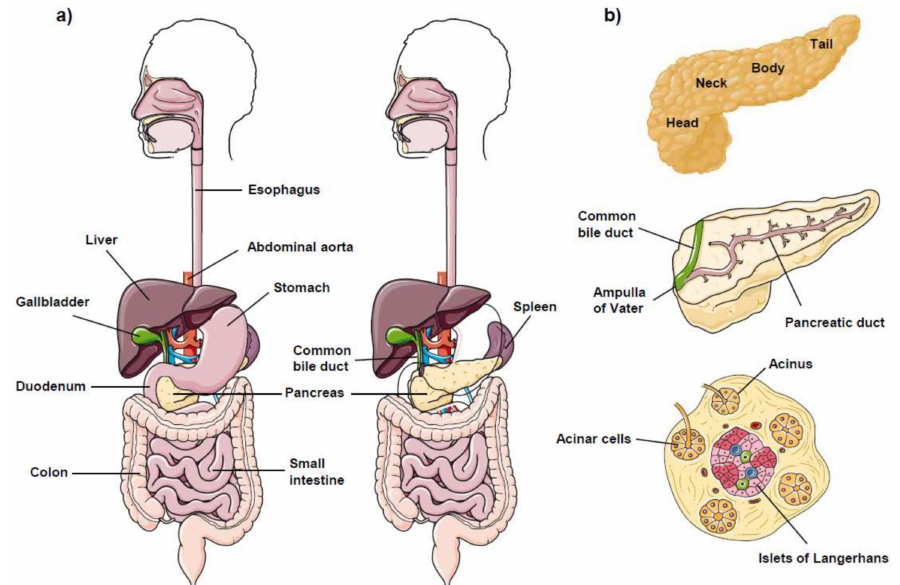
Figure 1. Pancreas anatomy. ( a ) Location and anatomical relationships between the pancreas and organs surrounding it in the abdomen. The pancreas is located behind the stomach, and the head of the pancreas is surrounded by the C-loop of the duodenum. ( b ) (Upper) The pancreas is divided into four major anatomical regions: head, neck, body, and tail. (Middle) The pancreatic duct extends from the tail to the head, and collects juices from all of the branches of the pancreatic stream. The pancreatic duct joins the common bile duct in the head of the pancreas to form the ampulla of Vater, which empties into the duodenum. (Lower) Most of the pancreas consists of exocrine tissue, producing pancreatic enzymes for digestion. The cells that synthesize and secrete digestive enzymes are clustered in grape-like bunches called acini (acinus, singular). These pancreatic acinar cells of the acinus synthesize, store, and secrete digestive enzymes that are drained into the pancreatic duct. The remaining tissue consists of endocrine cells called islets of Langerhans, which are clusters of pancreatic endocrine cells that produce and release hormones (such as insulin and glucagon) into the bloodstream regulating glucose levels. See text for